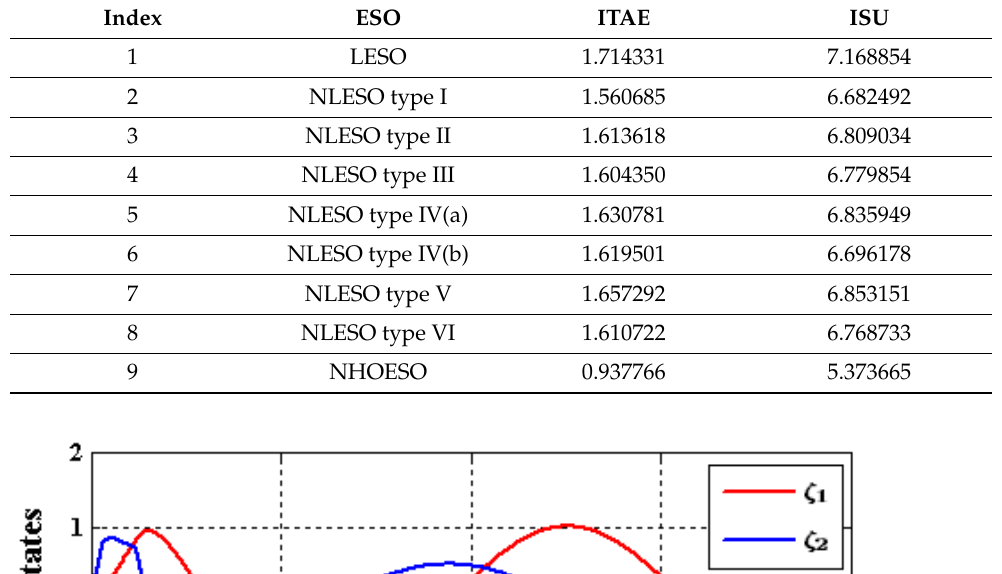
Table 3. The performance indices of the numerical simulations.